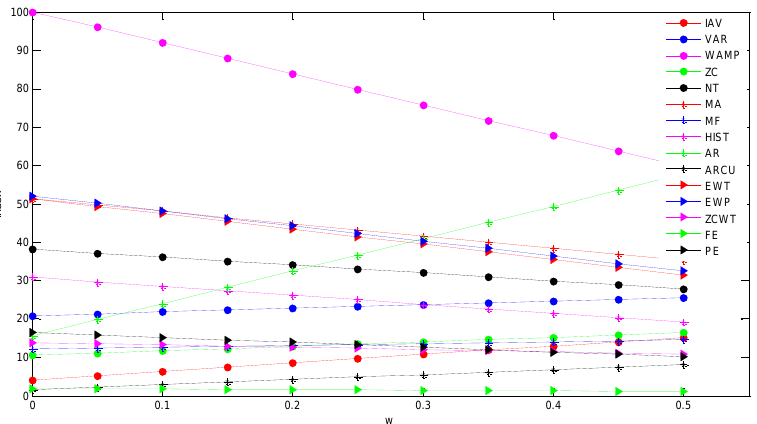
Figure 5. The separability index and calculation time of fifteen features.